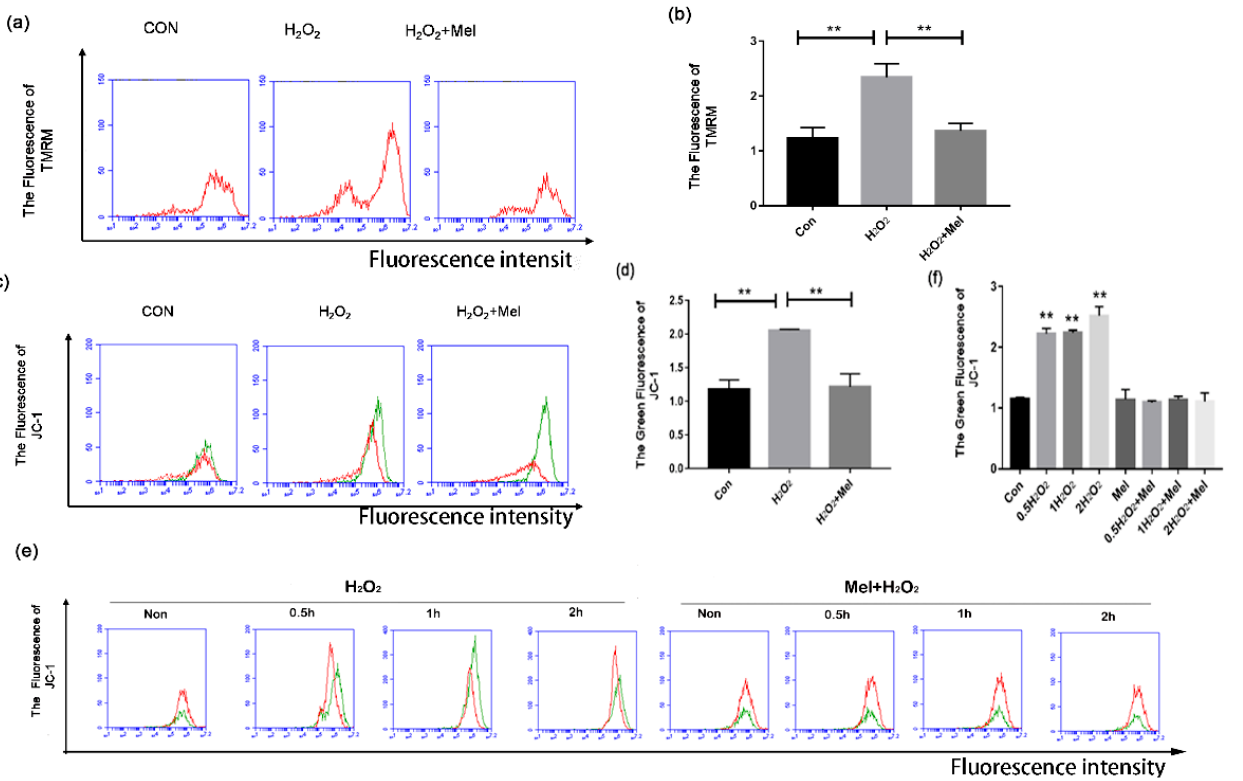
Figure 3. MEL alleviates oxidative damage in GC by inhibiting mitochondria. ( a , b ) GCs harvested from ovarian follicles were exposed to 200 µ M H 2 O 2 for 1 h, and then treated with 10 µ M MEL for 2 h. Mitochondria were stained with TMRM (red) and analyzed by FCM. ( c , d ) Mitochondrial membrane potential was monitored by a mitochondrial-specific dual fluorescence probe. GCs were treated with 200 µ M H 2 O 2 for 1 h and incubated with 10 µ M MEL for 2 h. Then, cells were incubated with JC-1 for 20 min and detected by FCM. ( e , f ) GCs treated with H 2 O 2 for 1 h were then cultured with 10 μ M MEL, and 0, 0.5,1 or 2 h later, JC-1 fluorescence was detected using FCM analysis. The +Y axis is 100 times the number of cells, and the +X axis is the intensity of cell fluorescence. Experiments were repeated in triplicate. Data represent mean ± S.E; n = 3. ** Represents p < 0.01 compared to control group.